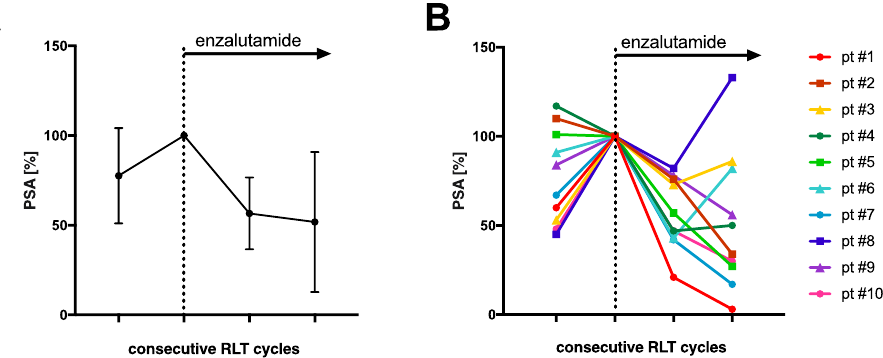
Figure 1. Relative serum PSA course under radioligand therapy prior to (last cycle of conventional PSMA-RLT) and after the start of enzalutamide medication ( A ) for all patients (mean and standard deviation) and ( B ) individually for each patient. PSA was normalized to 100% at start of enzalutam- ide.